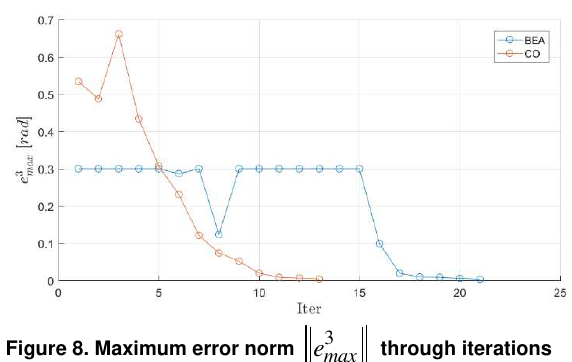
Figure 8. Maximum error norm